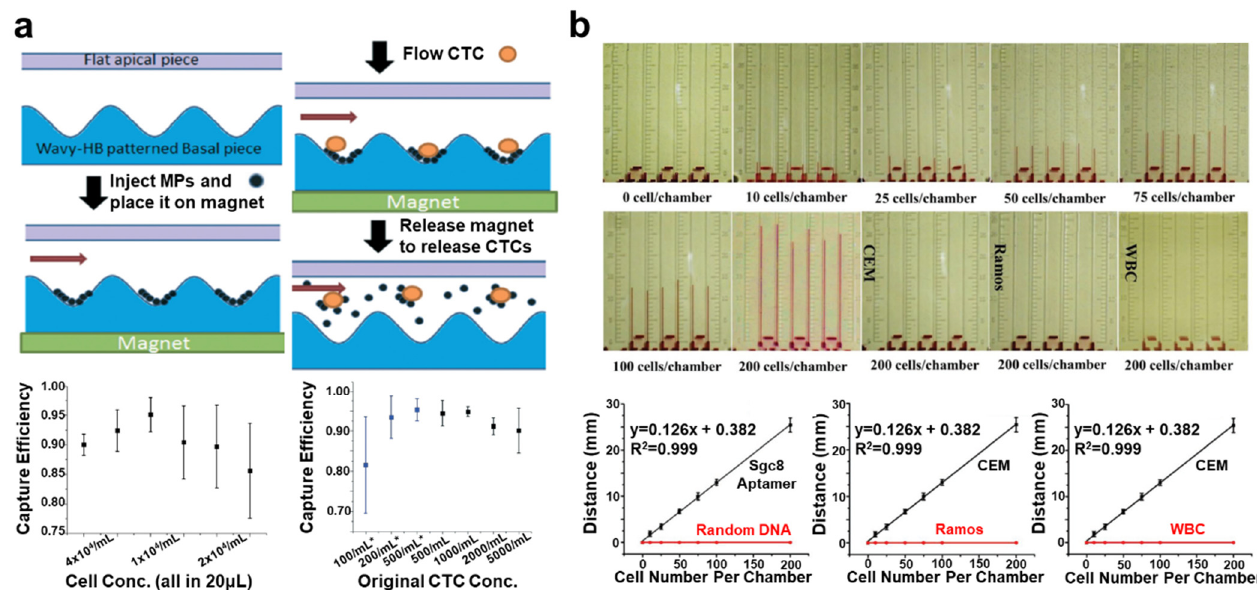
Figure 1. ( a ) Schematic images of capture, the release of circulating tumor cells (CTCs), and capture efficiency of CTCs using wavy-herringbone-structured microfluidic devices. This figure is reproduced from [40] (© 2017 The Royal Society of Chemistry); ( b ) Quantitative detection of CTCs using volumetric bar-chart chip by analysis of distance moved by ink, proportional to CTC concentration. This figure is reproduced from [41] (© 2019 John Wiley &